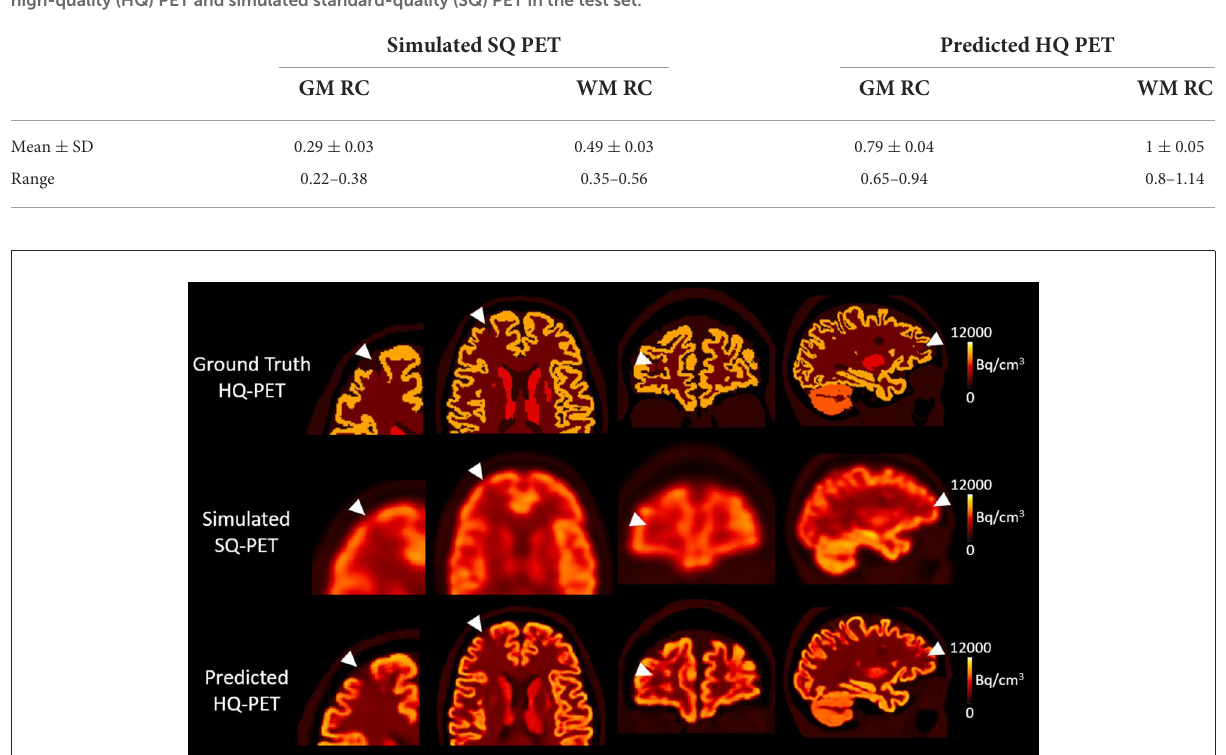
FIGURE4 Results from one subject belonging to the test dataset with a simulated right frontal hypometabolic lesion with a volume of 0.327 cm 3 . First column, enlarged view of the lesion in transverse view; second column, transverse view, third column, coronal view, fourth column, sagittal view. The relative lesion activity was 0.3 in the ground-truth high-quality-PET, 0.75 in the simulated standard-quality PET, and decreased to 0.44 in the predicted HQ-PET. Arrowheads indicate the location of the simulated lesion. Images are displayed using radiological conventions (subject’s left on the right). Bq, Becquerel cm 3 : centimetres cubed .